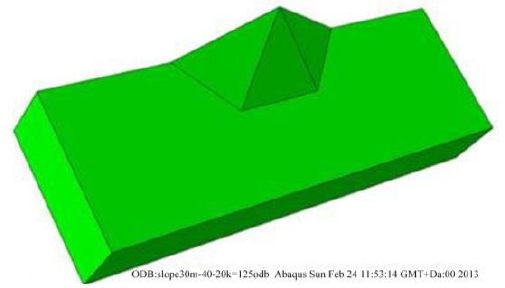
Figure 18. Model diagram of the ridge slope after slope cutting ( H =30m, α =30 ° , β =40°).